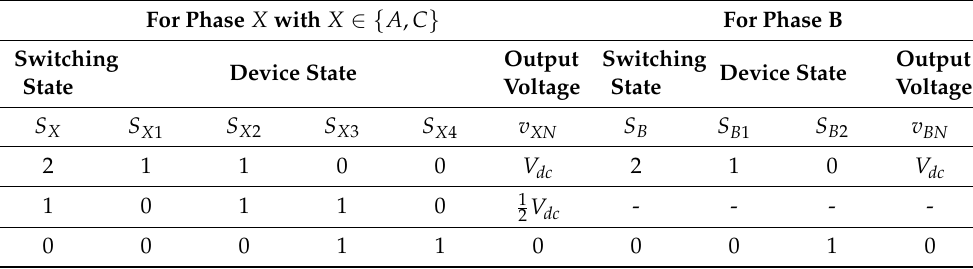
Table 1. Switching states and output voltages of the asymmetric inverter. For Phase 𝑿 with 𝑿 ∈ {𝑨, 𝑪}